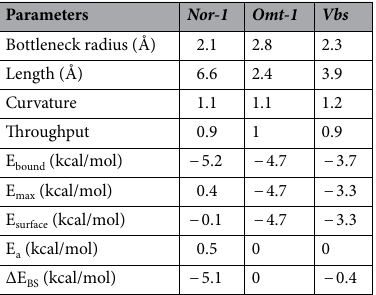
Table 5. CaverDock energy profile of all three target proteins.